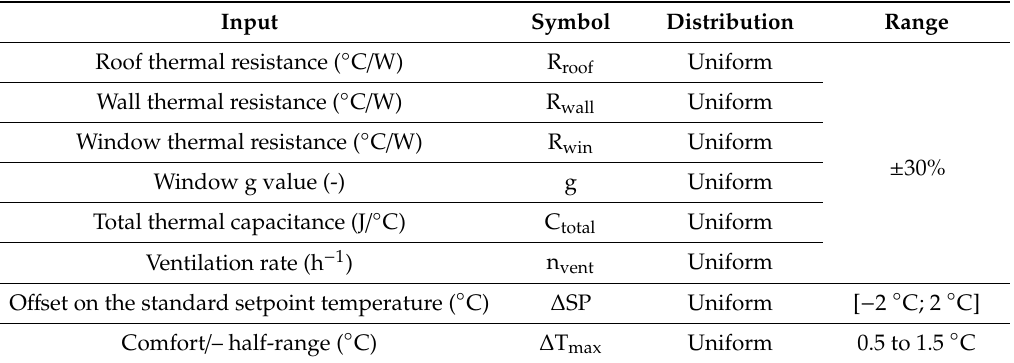
Table 3. Data and range of variation used in the sensitivity